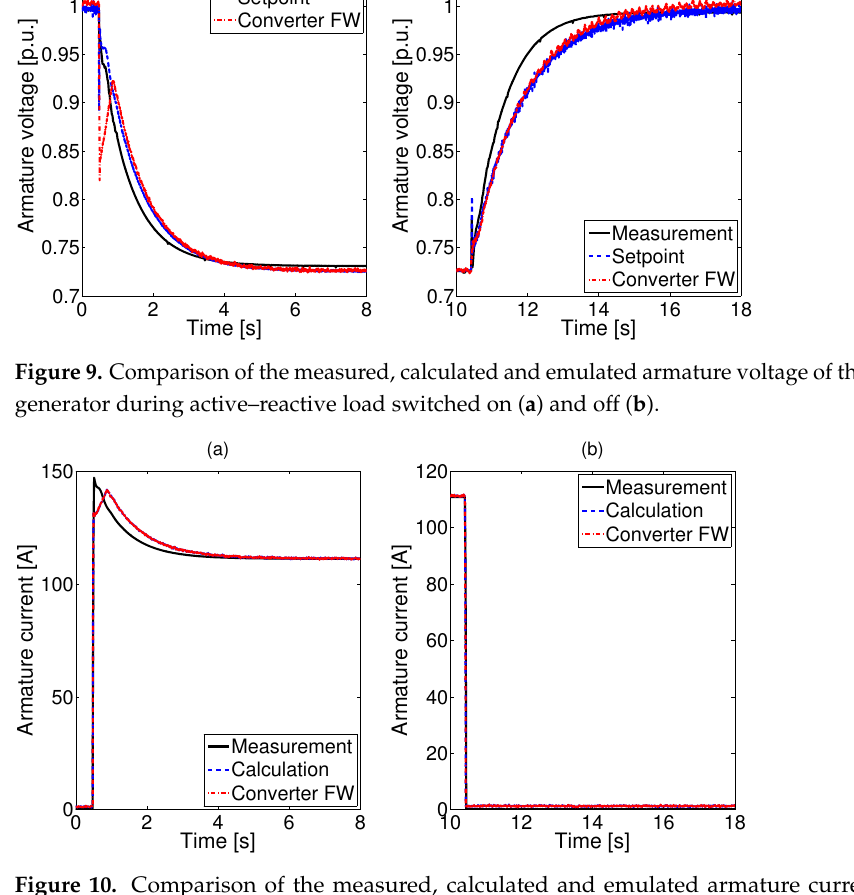
Figure 10. Comparison of the measured, calculated and emulated armature current of the syn- chronous generator during active-reactive load switched on ( a ) and off ( b ).